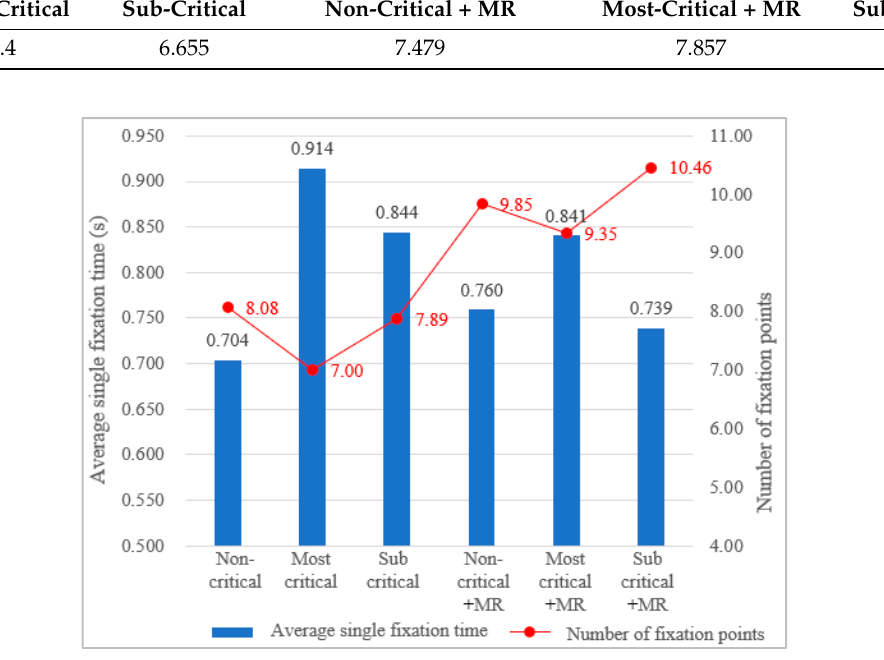
comparison of each scenario, the influence of light factor on the results was very limited. Therefore, pupil diameter was used to express the driver’s visual cognitive load and ten- sion. Normally, the pupil diameter of a person is between 2 and 6 mm. In special cases, the pupil diameter ranges from 1.5 to 8 mm. Figure 10 shows the change curve of pupil diameter of a driver in the most-critical scenario without MR before and after the taking over prompt. During the automatic driving, the pupil diameter of the driver fluctuated between 3.5–4.0 mm when being engaged in the secondary task. When the takeover com- mand sounded, the pupil diameter increased rapidly, and gradually decreased after reaching the maximum of 5 mm. Figure 10. Change of pupil diameter of both eyes during takeover process in the most-critical sce- nario without MR.